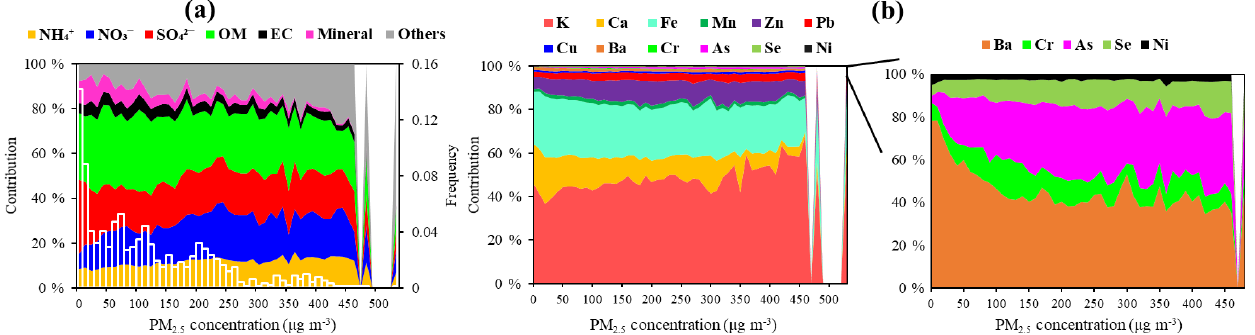
Figure 2. Variation in (a) chemical composition and (b) elemental species with PM 2 . 5 concentration. The white bars represent the frequency of PM 2 . 5